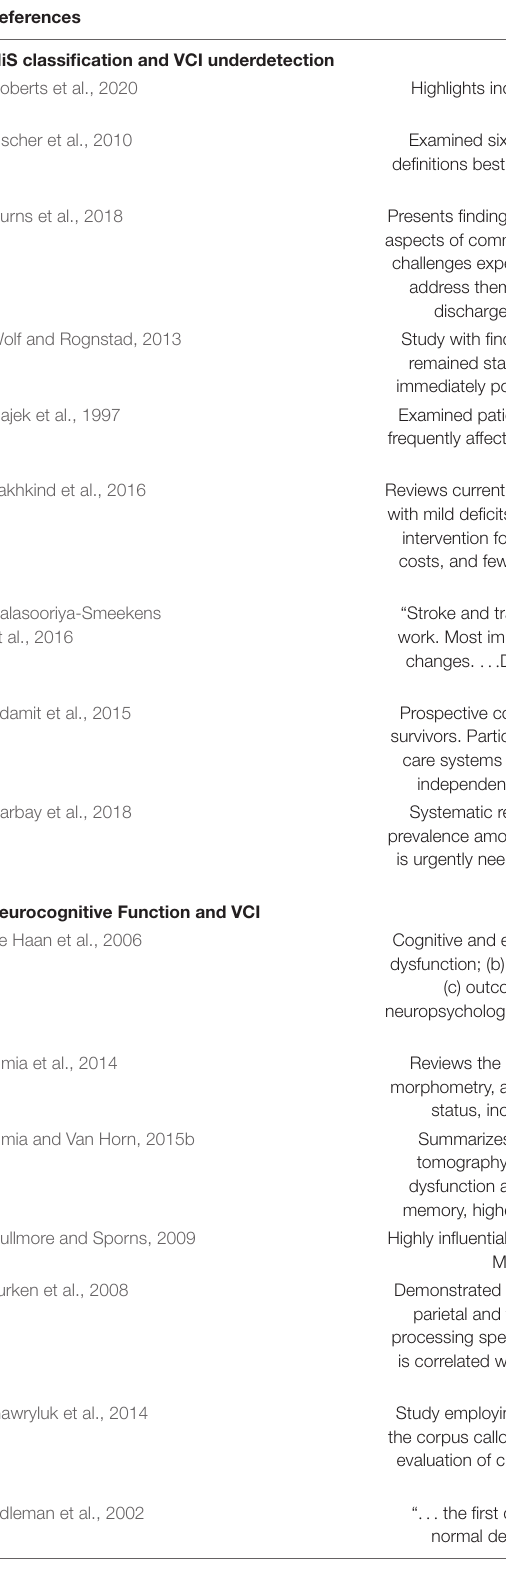
TABLE 1 | Summary of overarching constructs, themes, and seminal works within the reviewed